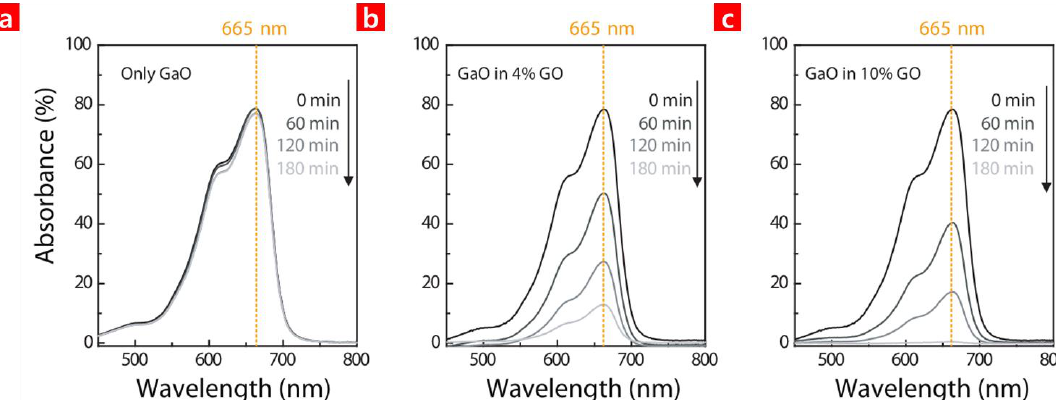
Figure 3. The absorbance spectra of the methylene blue (MB) solution where ( a ) GaO; ( b ) an HC of GaO and 4% GO; and ( c ) an HC of GaO and 10% GO were added to the MB. Each sample was exposed to 254 nm of radiation at different times.